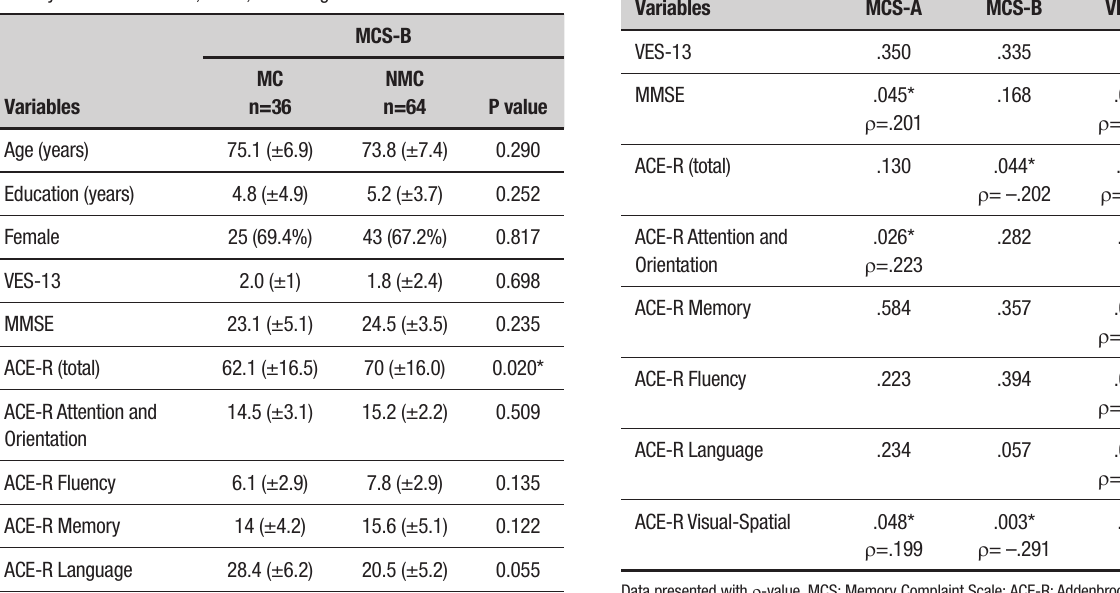
Table 3. Clinical characteristics of final sample of people aged 65+ living in a rural city in São Paulo state, Brazil, according to the MCS-B. 2016.